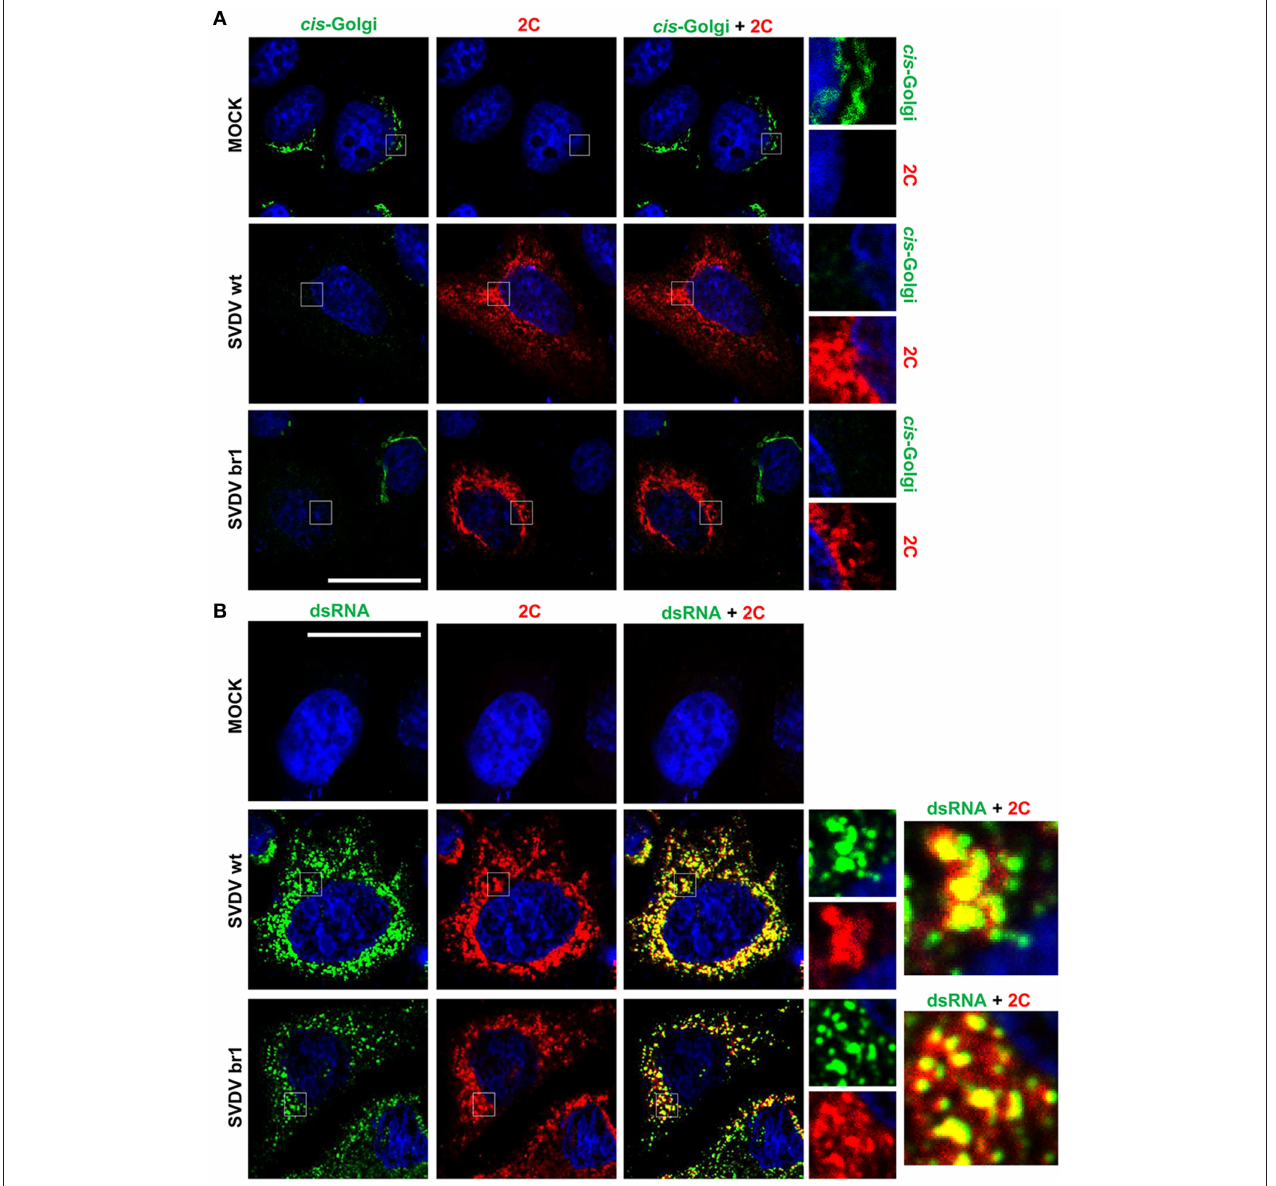
FIGURE 6 | Effect of the infection on Golgi complex and cellular localization of viral protein 2C. (A) IBRS-2 cells infected with SVDV wt or br1 (moi of 0.5 pfu/cell) and processed for double immunofluorescence, at 8 h pi, using MAb to GM130 ( cis -Golgi) or a rabbit polyclonal serum to 2C protein. (B) IBRS-cells infected and processed for immunofluorescence as in (A) using MAb to dsRNA or a rabbit polyclonal serum to 2C protein. The right panels represent the detail inside the box. Nuclei were stained using Topro-3. Bar: 20 µ